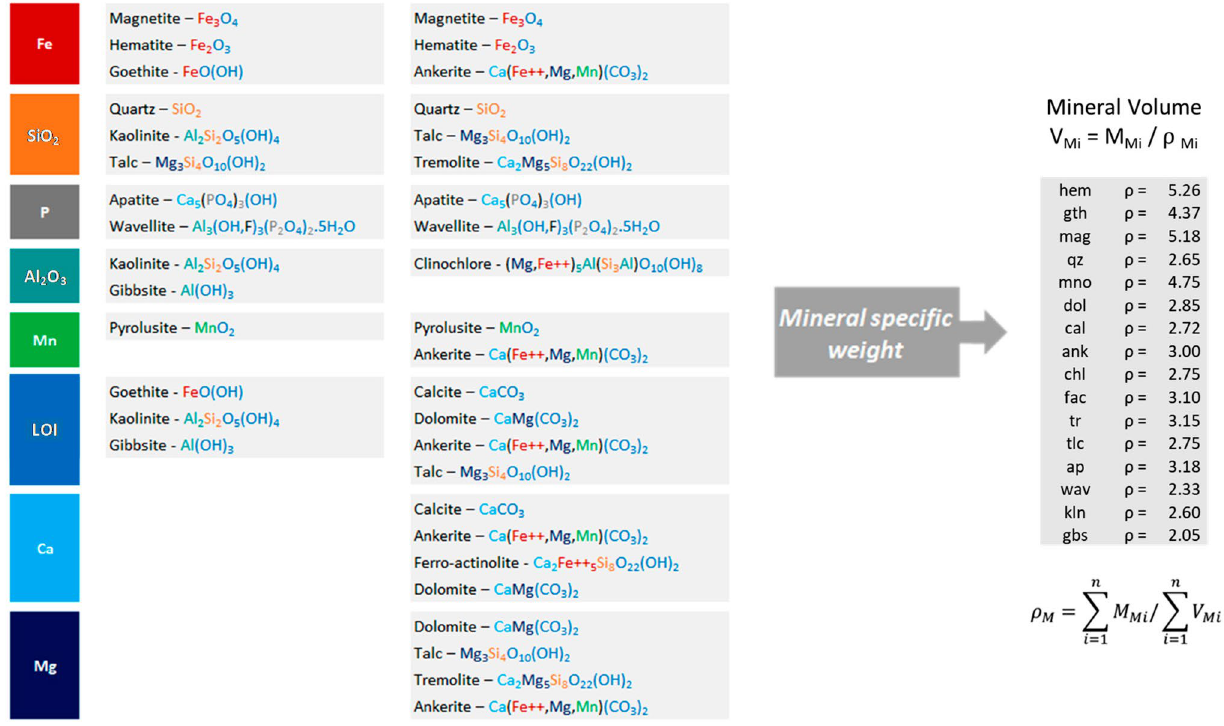
Fig. 3 Method of calculateion of mineral density from mineral proportion using MNC; extracted from Ribeiro et al.